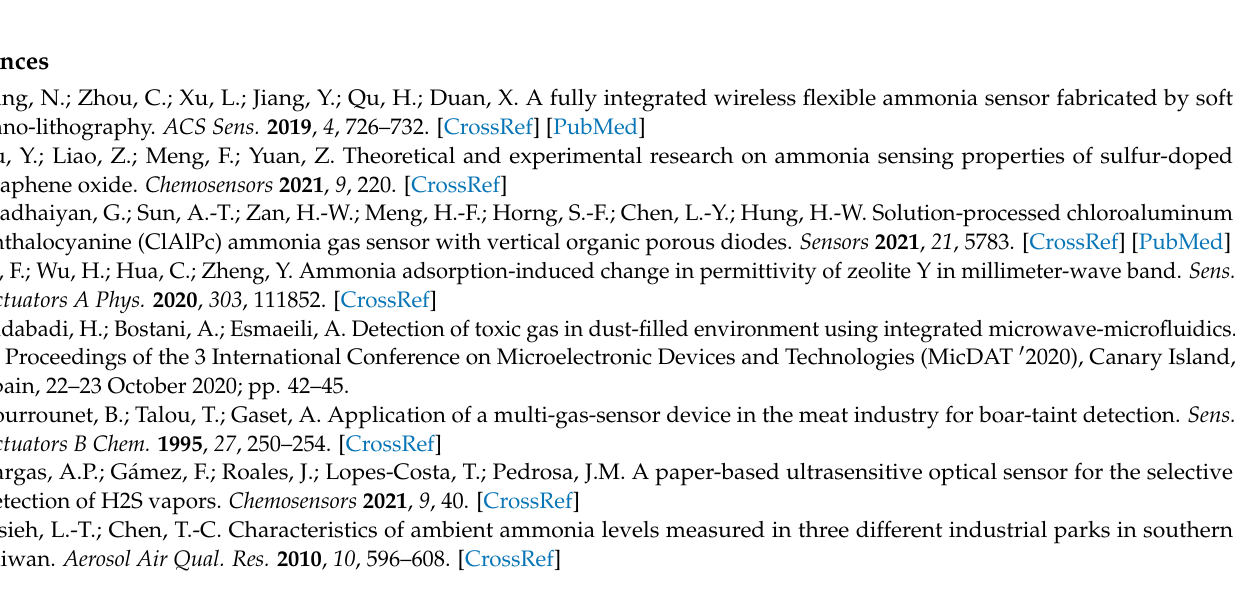
(Table A3) at 3 GHz and having the relative permittivity of zeolite Y in the original state, K’ g (Table A1), one can calculate the relative permittivity of zeolite Y for different concentration using the equation below: